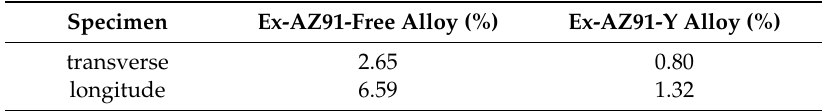
Figure 1. Microstructure morphologies of ( a ) transversal section and ( b ) longitudinal section of Ex-AZ91-free alloy; ( c ) transversal section and ( d ) longitudinal section of Ex-AZ91-Y alloy. Table 2. The volume fraction of the second phase of Ex-AZ91 alloy with and without rare earth element Y.